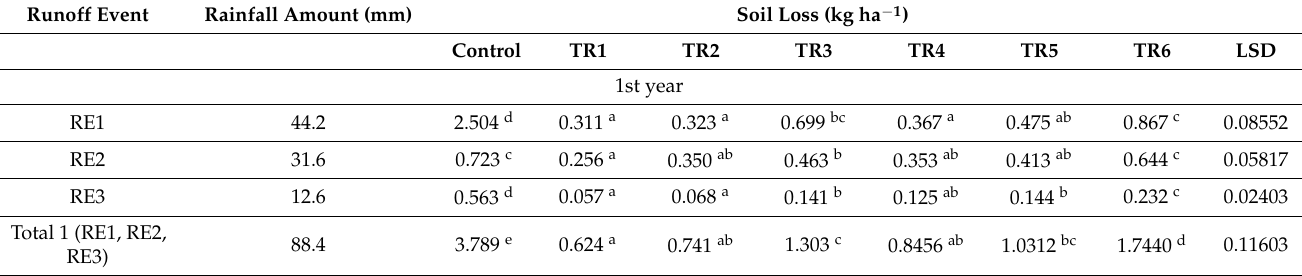
Table 5. Mean values of soil loss (kg ha − 1 ) volumes in the seven treatments of the two cultiva- tion